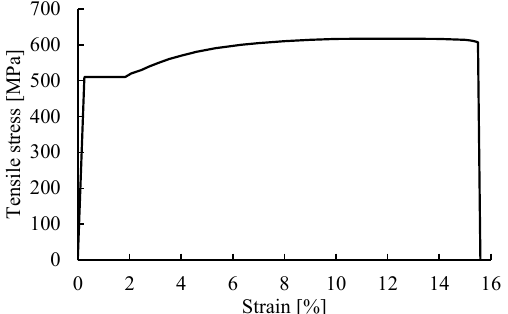
Figure 6. Tensile behavior defined for the steel reinforcement.